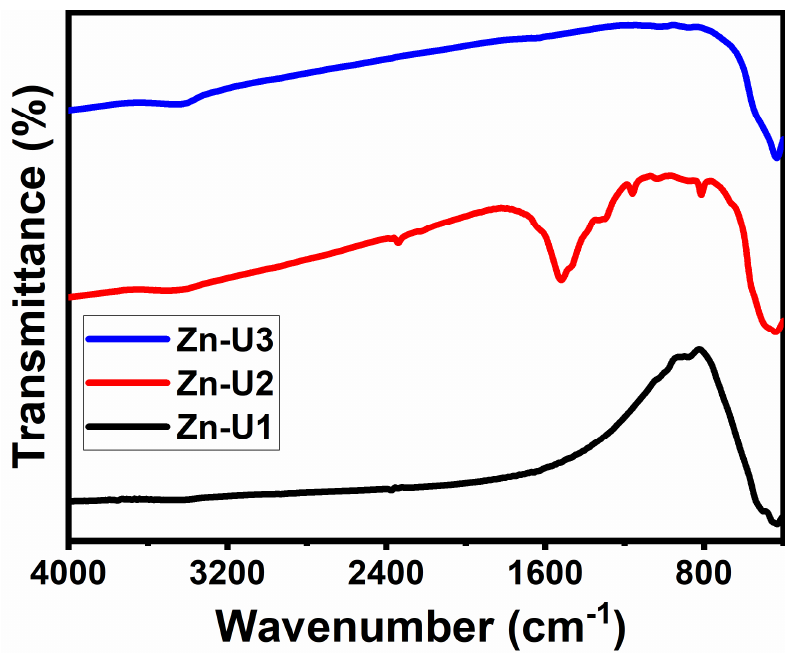
Figure 2. FTIR spectra of the Zn-U1, Zn-U2 and Zn-U3 nanocomposites.